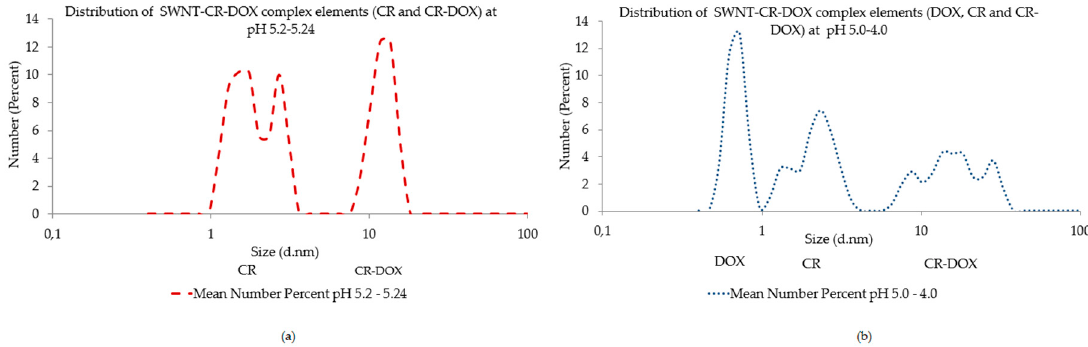
Figure 4. Hydrodynamic diameter distribution measurements. ( a ) number at pH 5.2–5.24 after rejection of large aggregates of more than 100 nm diameter, the release of CR-DOX complexes and free CR can be observed (the average of 5 measurements is presented) ( b ) number at pH 5.0–4.0 after rejection of large aggregates of more than nm diameter, the release of free DOX can be observed (the average of 12 measurements is presented).